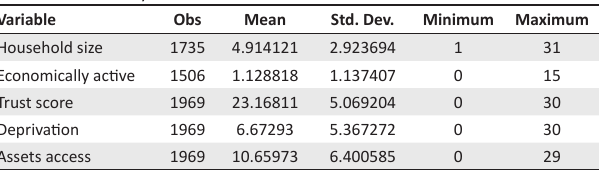
TABLE 12: Summary statistics.